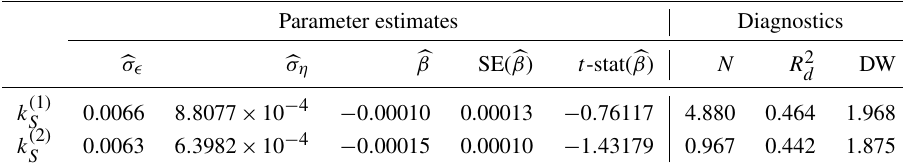
Table 3. Univariate analysis of the CO 2 sink rate.